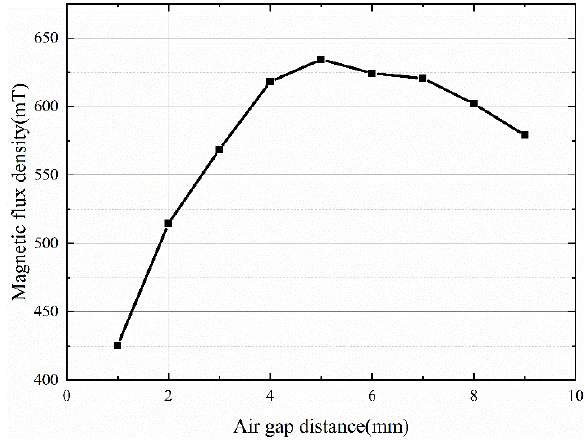
Figure 6. Influence of the air gap distance on the magnetic field.